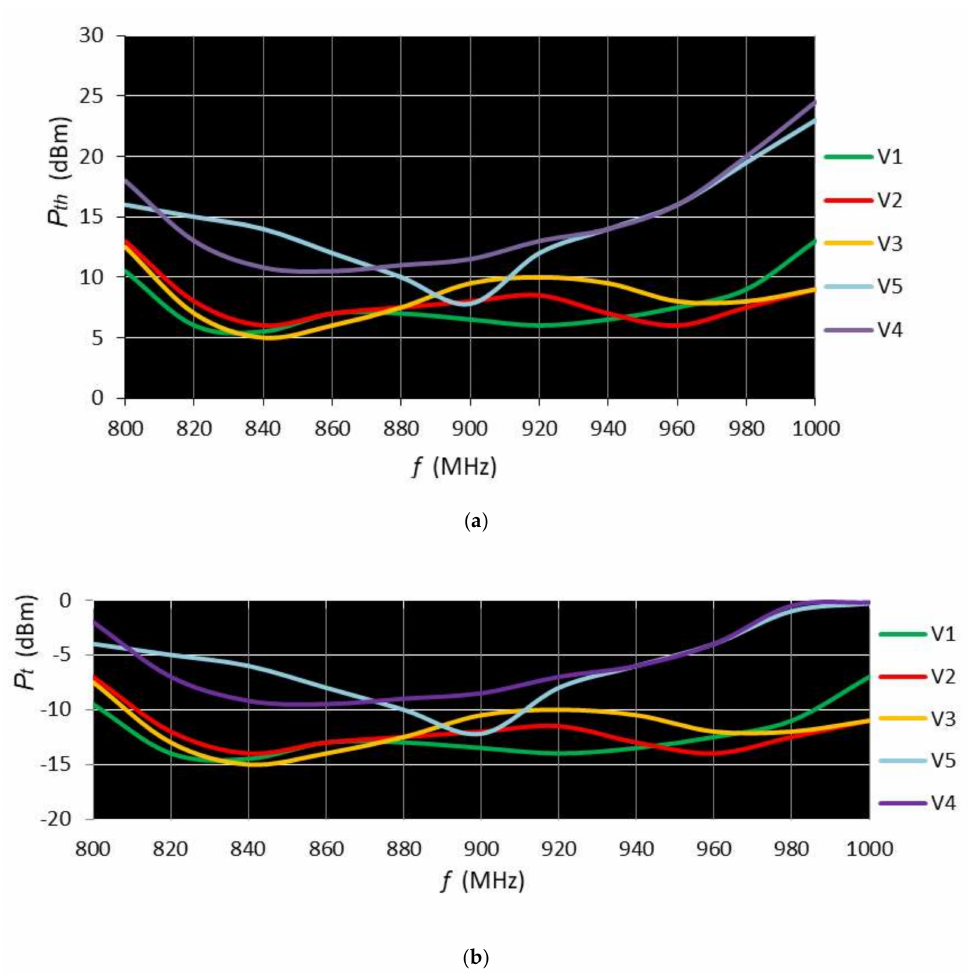
Figure 10. The power of the tags in 800–1000 MHz frequency range: ( a ) Threshold power P th ; ( b ) power on tag forward P t